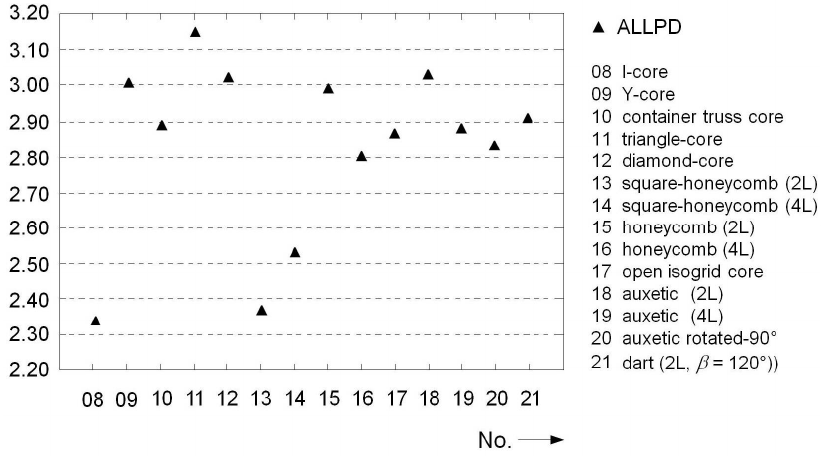
Figure 24. Prismatic cores: normalized maximum values for plastic dissipation